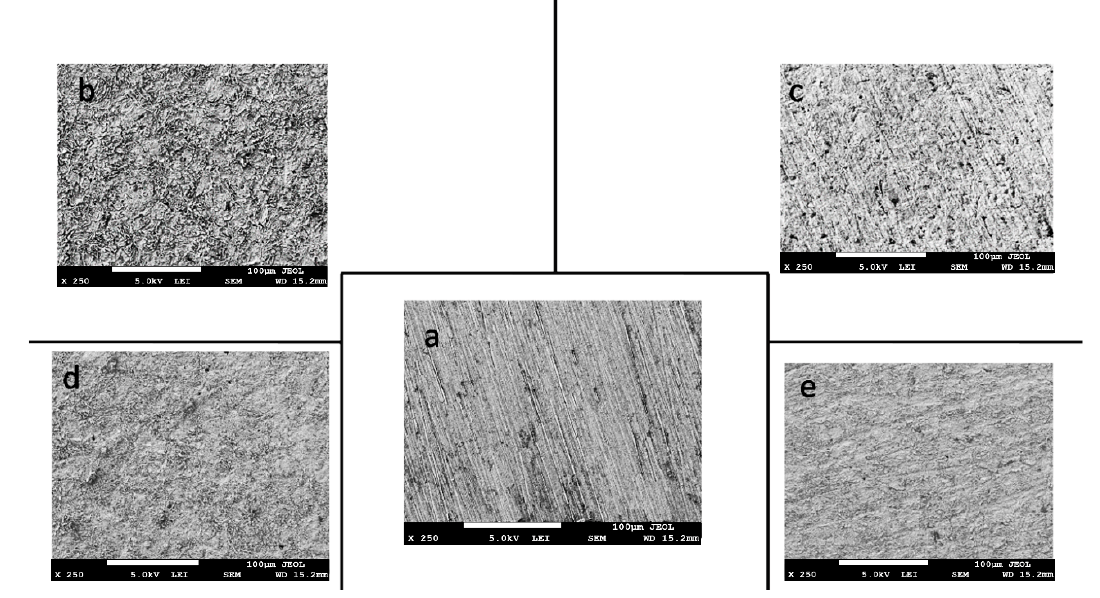
Figure 10. SEM images for ( a ) polished steel, ( b ) steel immersed in free 2 M H 2 SO 4 , ( c ) steel immersed in free 2 M 2 M H 3 PO 4 , ( d ) steel immersed in 2 M H 2 SO 4 in the presence of 5% ASMS, and ( e ) steel immersed in 2 M H 3 PO 4 in the presence of 5% ASMS.